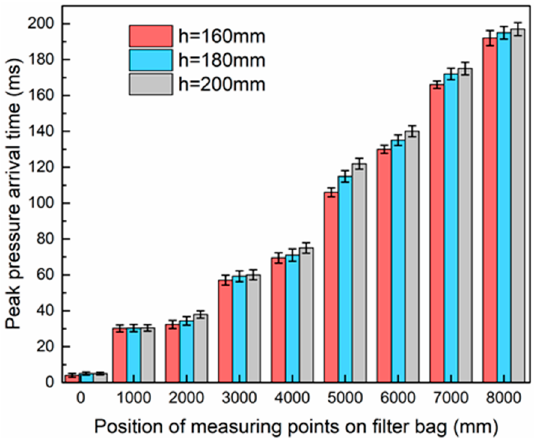
Figure 11. Effect of venturi length on the arrival time of peak pressure.